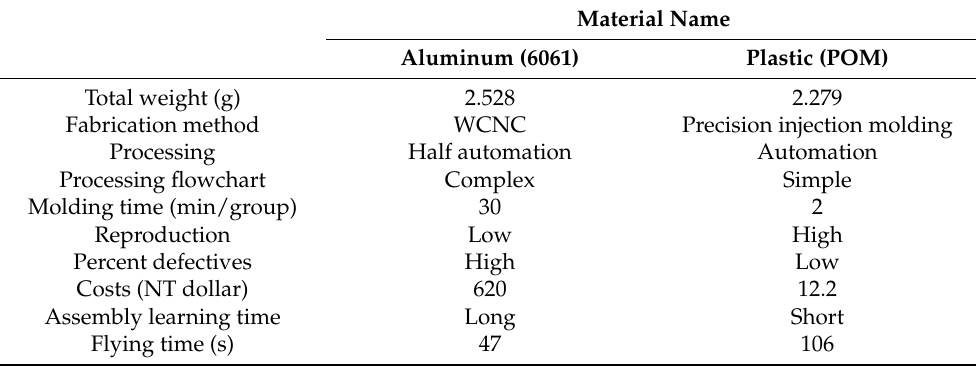
Table 8. Comparison results of the transmission structure of the flapping-wing MAV between aluminum alloy material and plastic